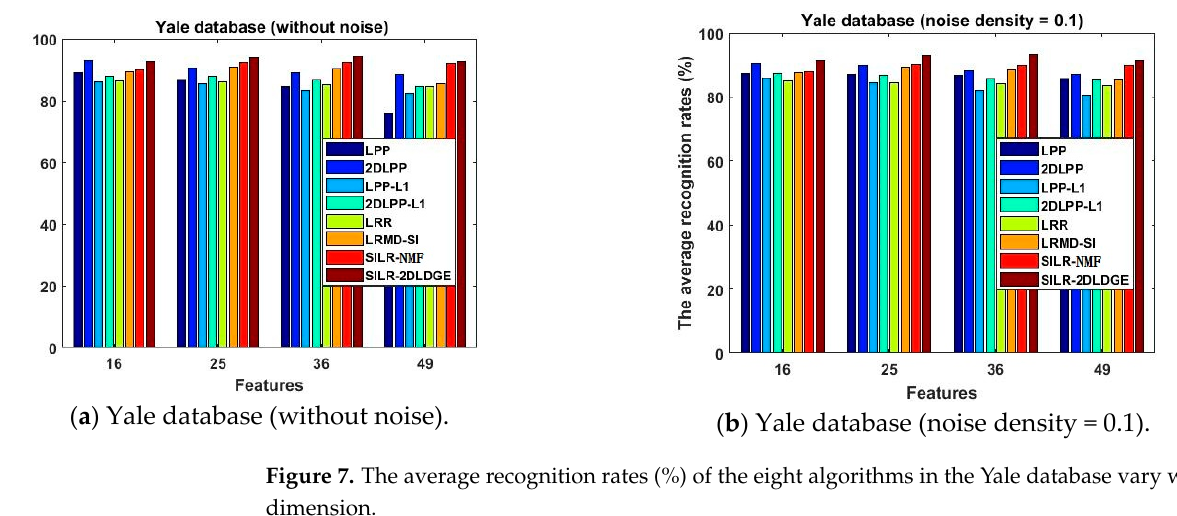
Figure 6. Some the original images and corrosion images on the three different databases. ( a ) Yale, ( b ) AR, and ( c ) PolyU.